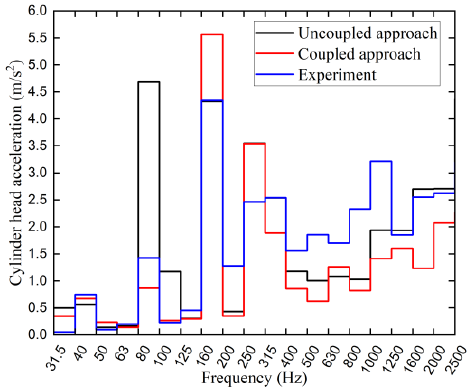
Figure 26. The 1/3 octave of measuring point 2 acceleration comparison between two approaches.